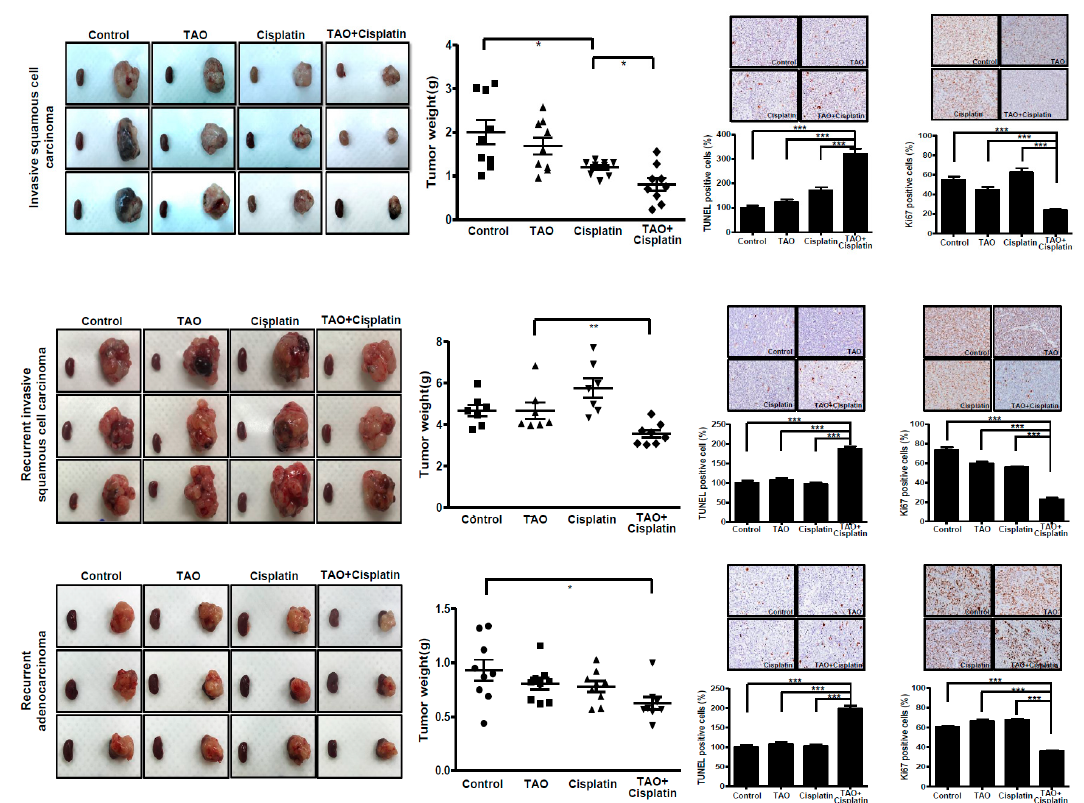
Figure 6. Gross appearance of xenograft from mouse models receiving PBS, TAO (8 mg / kg), cisplatin (4 mg / kg), and TAO plus cisplatin (8 mg / kg of TAO and 4 mg / kg of cisplatin) in order from left to right. Significant reductions of tumor weight in mouse models given TAO plus cisplatin are observed in primary invasive squamous cell carcinoma as well as in recurrent invasive squamous cell carcinoma and adenocarcinoma. The TUNEL assay and Ki-67 assay results also support the synergistic effects of TAO with cisplatin, both in primary and recurrent cancer models. * p -value < 0.05, ** p -value < 0.01, *** p -value < 0.001.